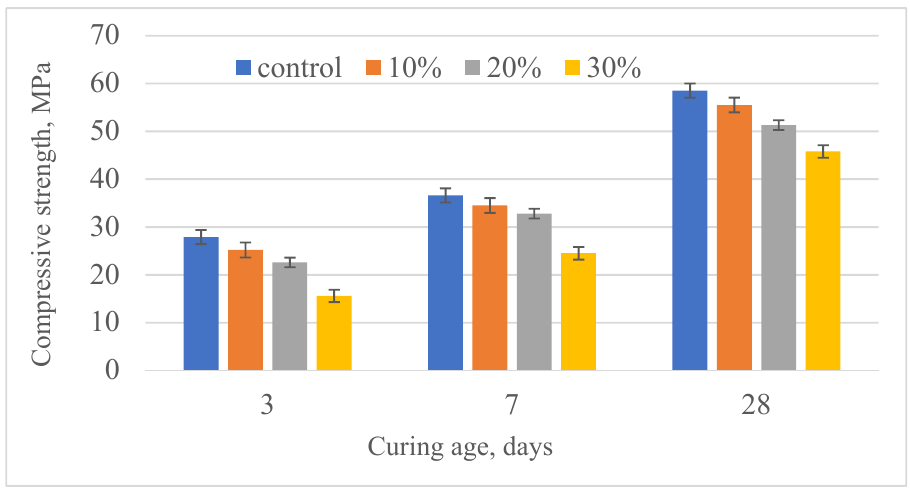
Figure 9. Compressive strength results of calcined clay blended mortar at varying percentages.